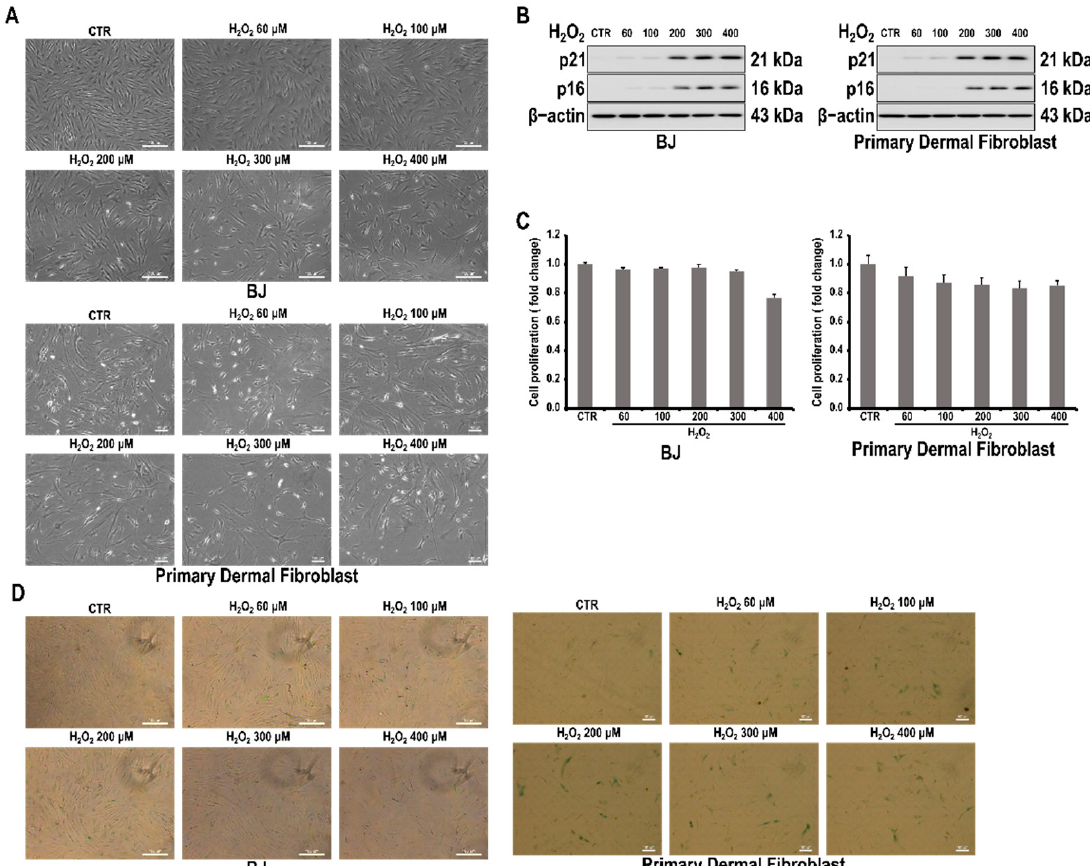
Figure 1. H 2 O 2 -induced cell senescence in skin fibroblast cells. Cells were treated with varying concentrations of H 2 O 2 for 24 h. ( A ) Representative bright field images of skin fibroblasts after H 2 O 2 treatment. ( B ) Effect of H 2 O 2 on the expressions of p16 and p21 in skin fibroblasts. ( C ) Effect of H 2 O 2 on the proliferation of skin fibroblasts, as determined by the MTT assay. ( D ) Representative images of H 2 O 2 -treated skin fibroblasts stained for senescence-associated β -galactosidase after H 2 O 2